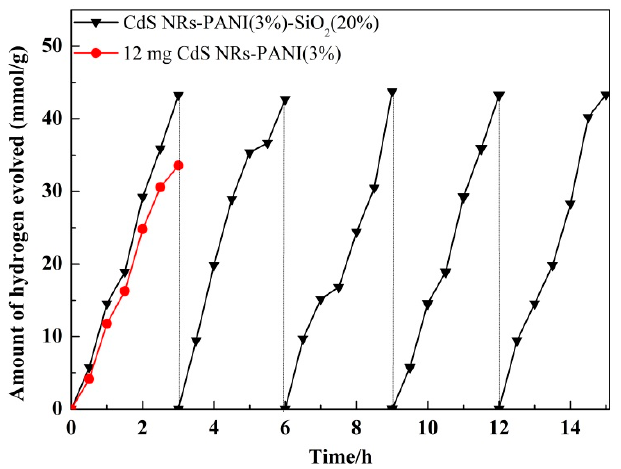
2 (20%) at different wavelengths. Figure 11. AQE of CdS NRs-PANI (3%)-SiO